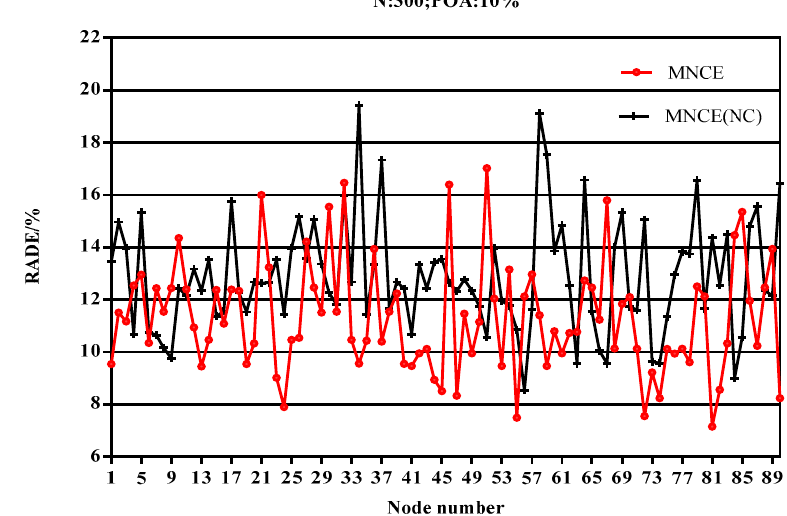
Figure 7. Impact of the error-correction rate on estimated distance error (RADE).